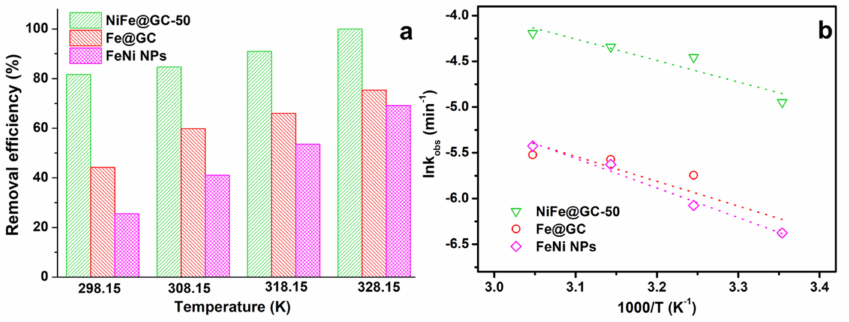
Figure 7. ( a ) Effects of temperature on the removal efficiency, ( b ) the Arrhenius plot for the estimation of activation energy. (Experimental conditions: TCP = 30 mg L − 1 , pH = 3.0, dosage = 0.5 g L − 1 ).